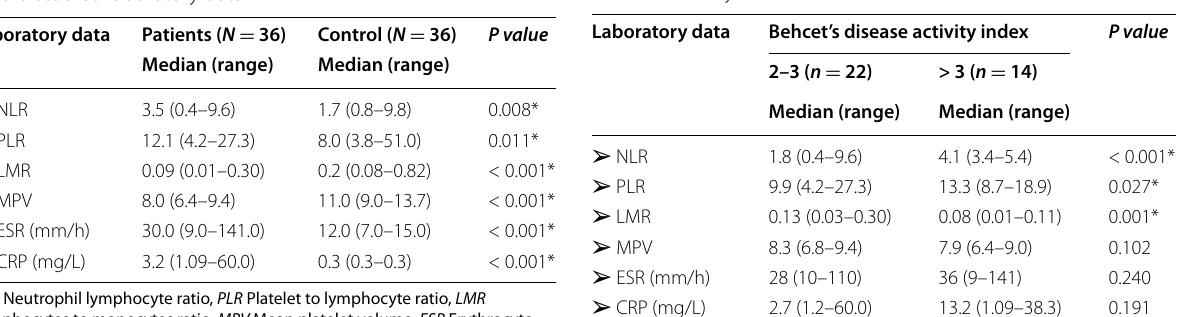
Table 4 Comparisons of studied laboratory data as